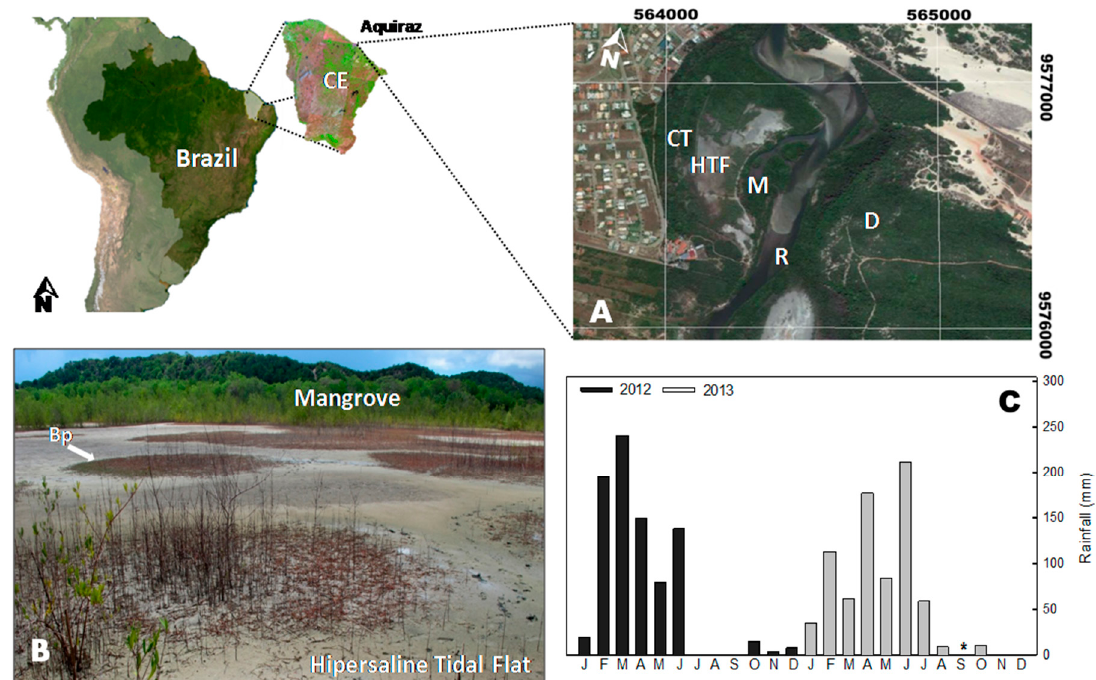
Figure 1. ( A ) Map of the study site (Pacoti River estuary, Aquiraz, Ceará state, Brazil), distinguishing the coastal tableland (CT), the studied hypersaline tidal flat (HTF), the associated mangrove (M), the Pacoti river (R), and the costal dunes (D). ( B ) Landscape of the studied site, showing the patchy distribution of Blutaparon portulacoides (Bp) and mangrove forest at the background. ( C ) Average monthly precipitation of the Pacoti estuary for 2012 and 2013 (studied years). Data from FUNCEME database of historical precipitation records. The * represents missing data.